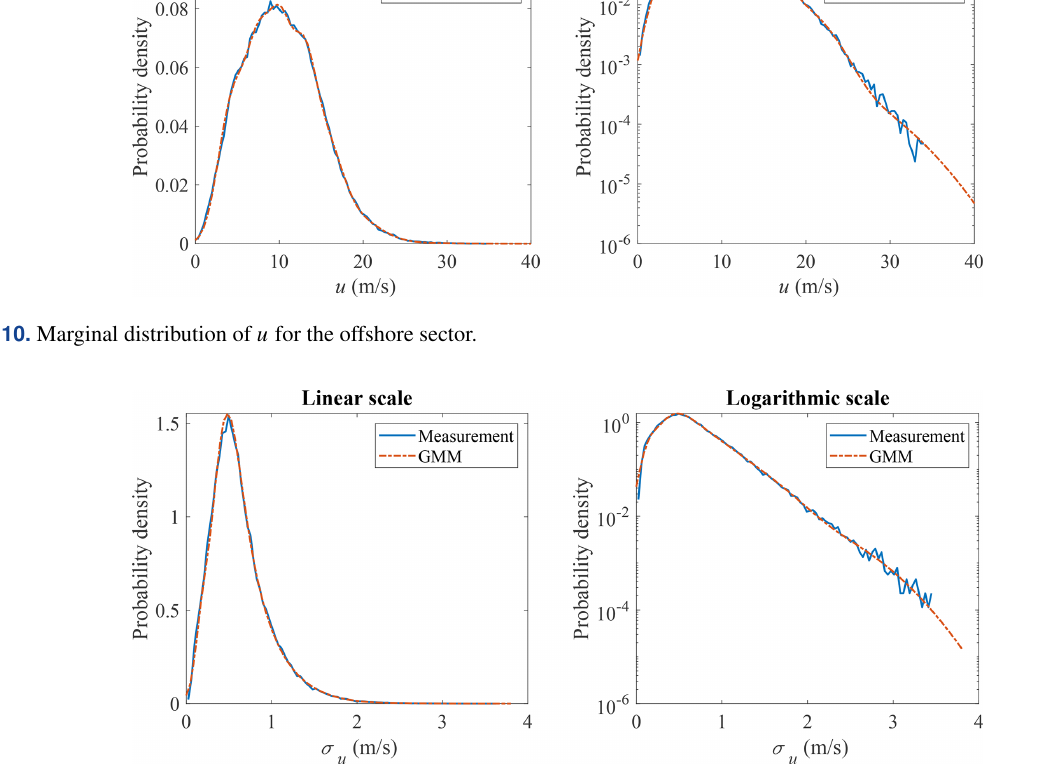
Figure 11. Marginal distribution of σ u for the offshore